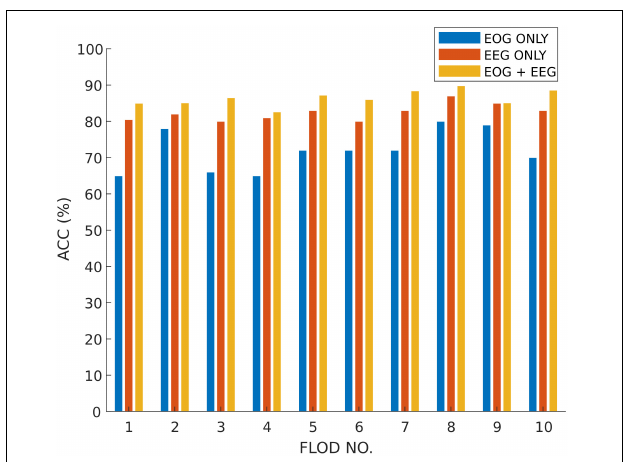
FIGURE 4 | The accuracy of classification experiments based on